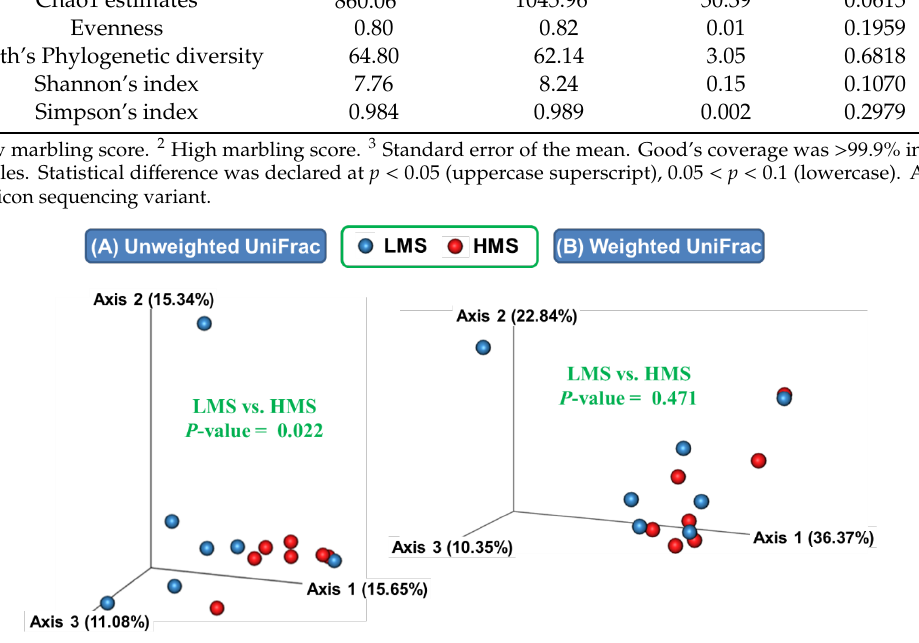
Figure 1. Principal coordinates analysis based on both unweighted ( A ) and weighted ( B ) UniFrac distances of prokaryotic populations in the rumen of Korean beef cattle. PERMANOVA was computed for non-parametric statistical tests between low marbling score (LMS) and high marbling score (HMS) groups.